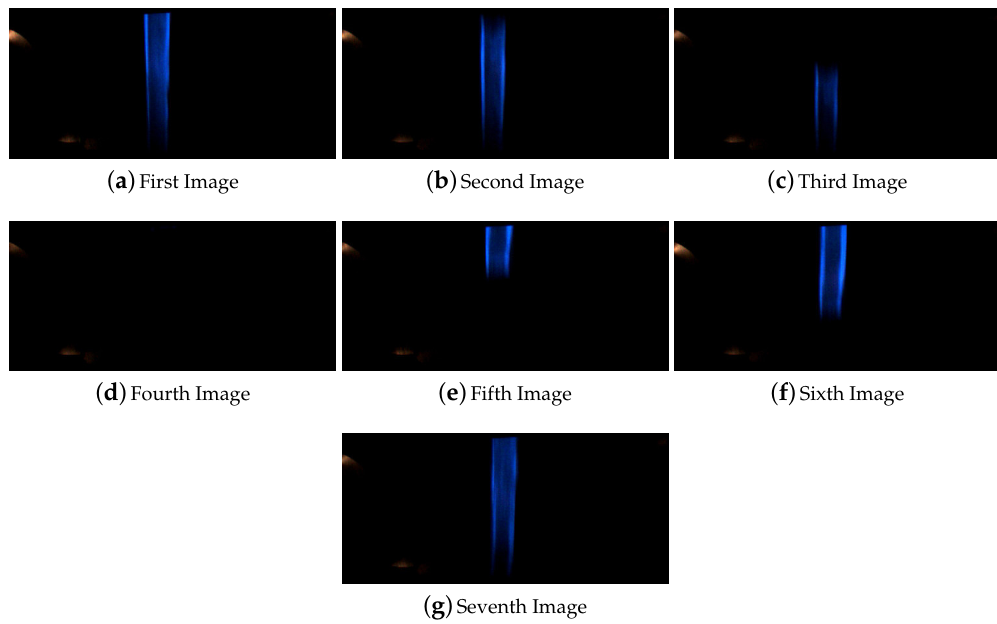
Figure 10. Sequence of images for the line occlusion for 50 cm inside a straight line.